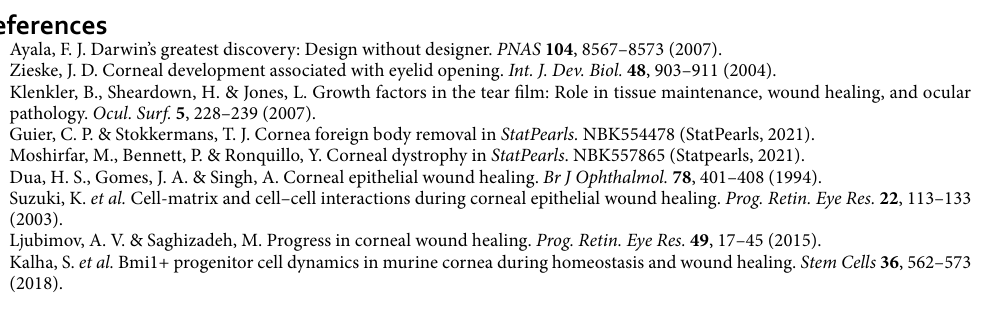
Illustrations. All figure panels were designed and produced with Adobe Illustrator 2021, including the sche- matic drawing of the Fig.